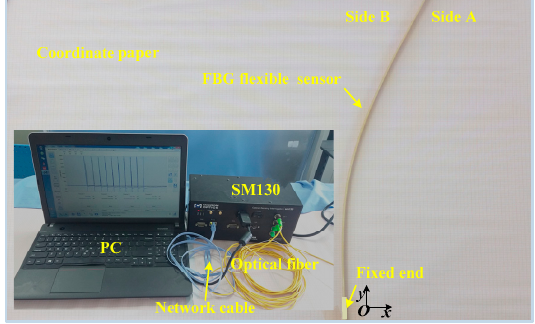
Figure 10. Schematic diagram of the experimental facility.